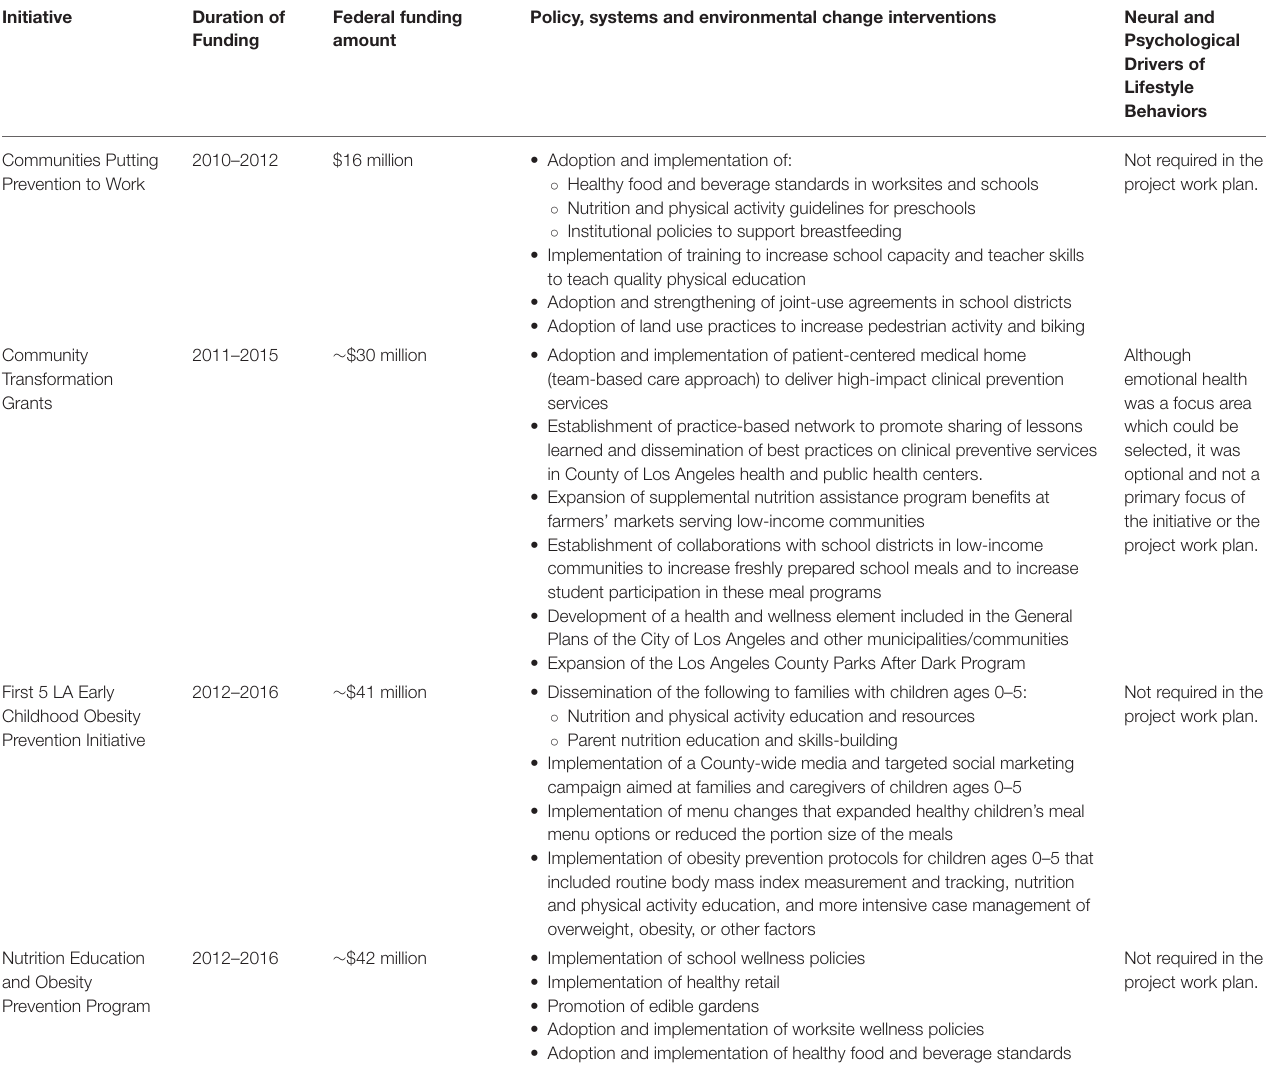
TABLE 1 | Obesity prevention initiatives implemented in Los Angeles County, 2010–2016.